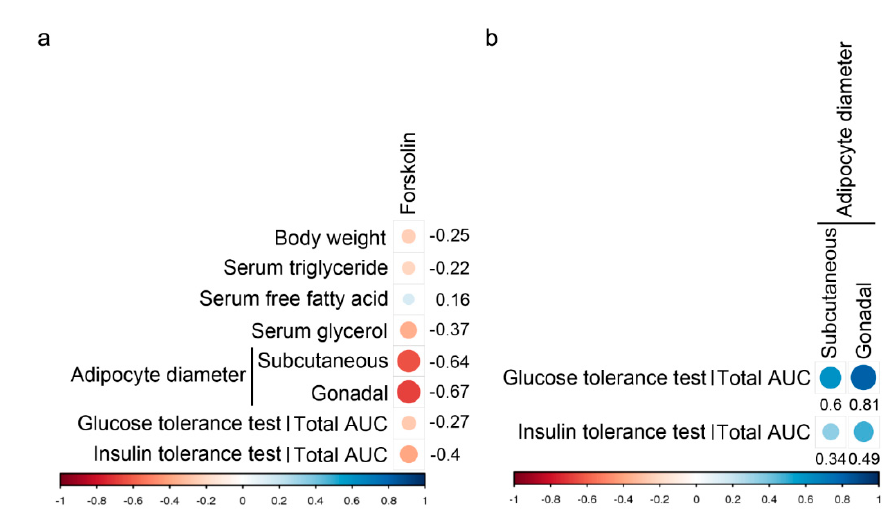
Figure 4. Effect of forskolin on adipocyte differentiation. ( a ) Oil-Red O staining of forskolin-treated mesenchymal stem cells after stimulation using an adipogenic induction cocktail for 8 days to promote differentiation. Three experiments (n = 3) were carried out and one representative result is shown. ( b ) Relative triglyceride content quantified via Oil Red O staining in forskolin-treated mesenchymal stem cells after stimulation using an adipogenic induction cocktail for 8 days. Three experiments (n = 3) were carried out. The bars indicate mean ± SD. a–c Means with no common superscript are significantly different ( p ≤ 0.05). ( c ) glycerol levels of culture medium in forskolin-treated mesenchymal stem cells after stimulation using an adipogenic induction cocktail for 8 days. Three experiments (n = 3) were carried out. The bars indicate mean ± SD. a,b Means with no common superscript are significantly different ( p ≤ 0.05). ( d ) mRNA expression of glucose transporter 4 (glut4) in mesenchymal stem cells treated with the adipogenic induction cocktail and forskolin for 8 days (n = 3). The bars indicate mean ± SD. a,b Means with no common superscript are significantly different ( p ≤ 0.05).